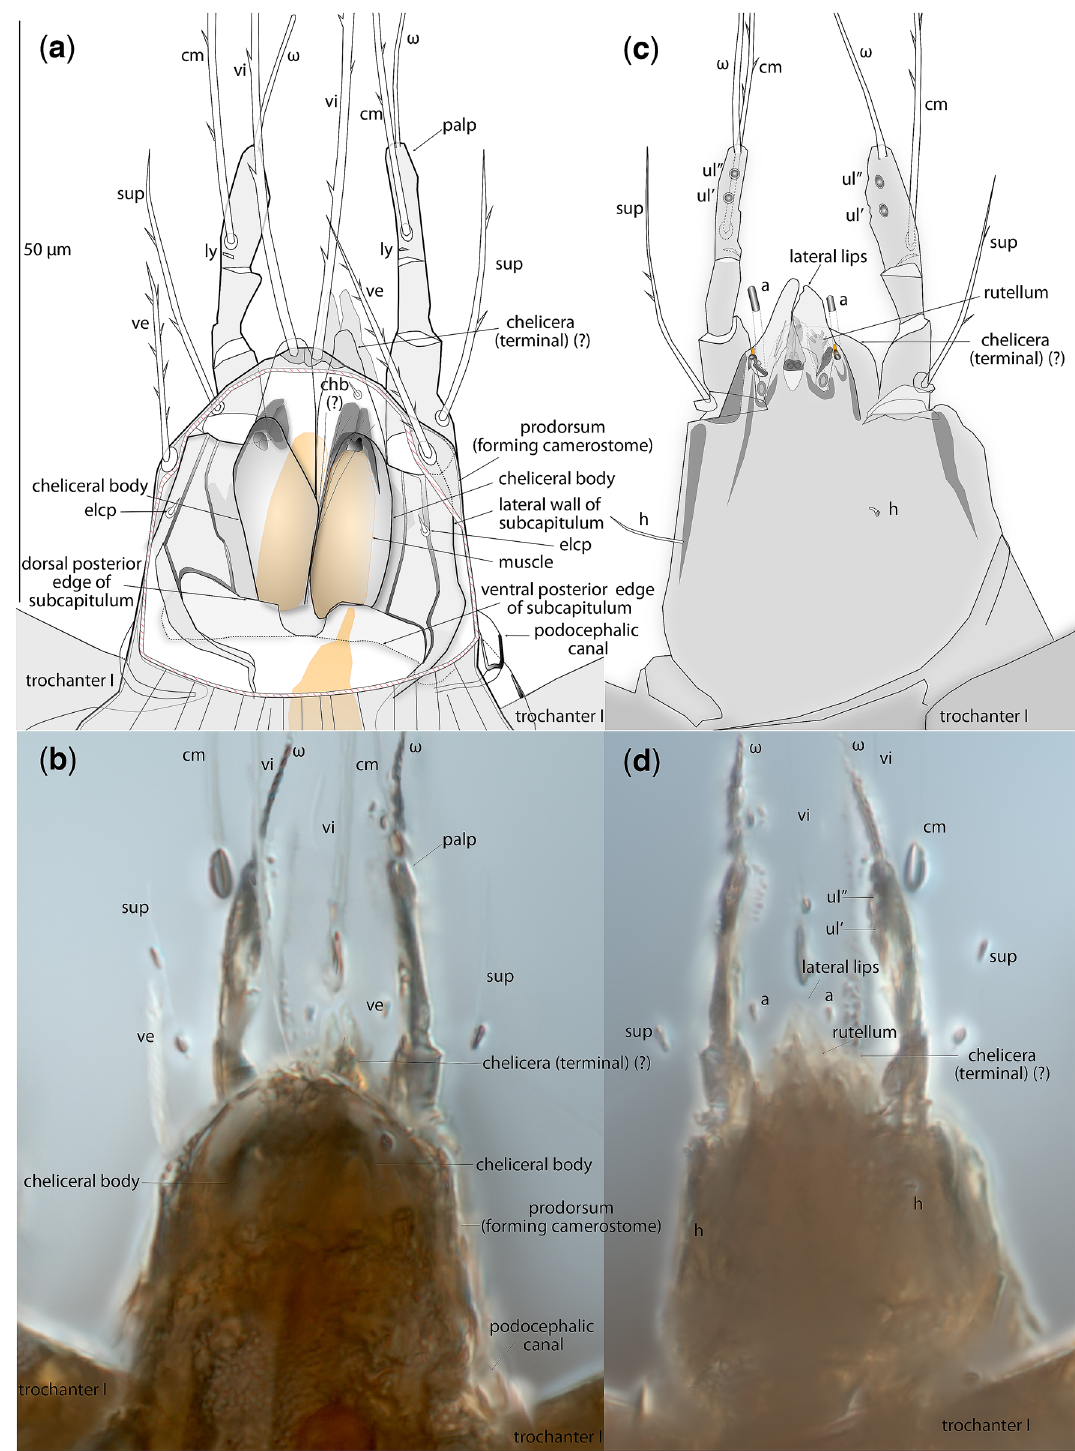
Figure 3. Levantoglyphus sidorchukae n. gen. and sp., phoretic heteromorphic deutonymph (holotype 1213A), gnathosoma, dorsal view ( a , b ), dorsal portion of camerostome removed to show internal structures ( a ), ventral view ( c , d ), line drawing ( a , c ) and photograph ( b , d ). Not all structures are well visible on photographs due to their low